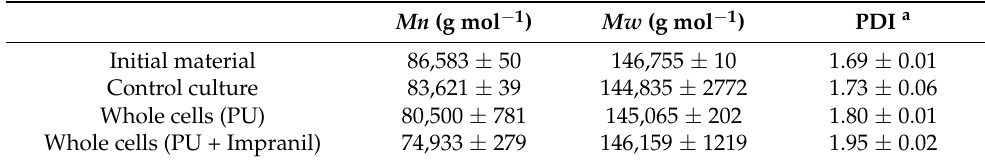
Table 1. Molecular weight and number ( Mw , Mn ) and polydispersity index of PU material after A. mediterranei ISP5501 whole-cell